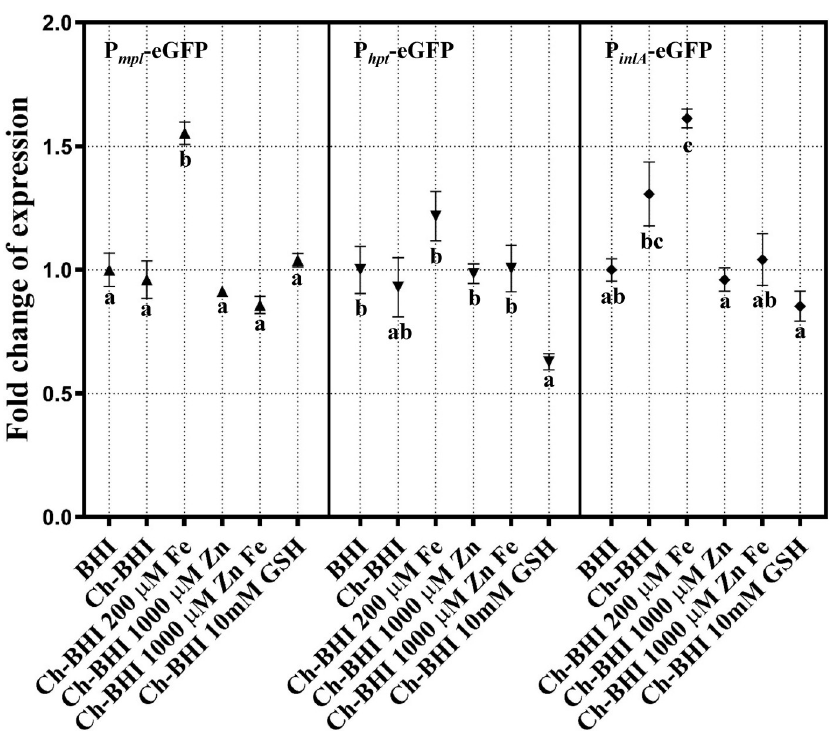
Fig 5. Differential expression of P -eGFP, P -eGFP and P -eGFP. L . monocytogenes strains expressing P - inlA hpt mpl inlA eGFP ( ♦ ), P hpt -eGFP ( ▼ ) and P mpl -eGFP ( ▲ ) reporter fusions were grown in BHI or Ch-BHI with or without 200 μ M iron, 1,000 μ M zinc or 10 mM glutathione. GFP fluorescence levels were measured and normalized by culture OD 600 . Fold change of expression (for graphing purpose) was calculated as a ratio of normalized GFP fluorescence level relative to the normalized fluorescence level of L . monocytogenes cells expressing the reporter fusion and growing in untreated BHI. Statistical analysis was done using the GFP/OD 600 data from at least 3 independent biological replicates; error bars represent SEM. Conditions that share the same letter are not significantly different ( p- value > 0.05) as determined by two-way ANOVA and Tukey’s post hoc